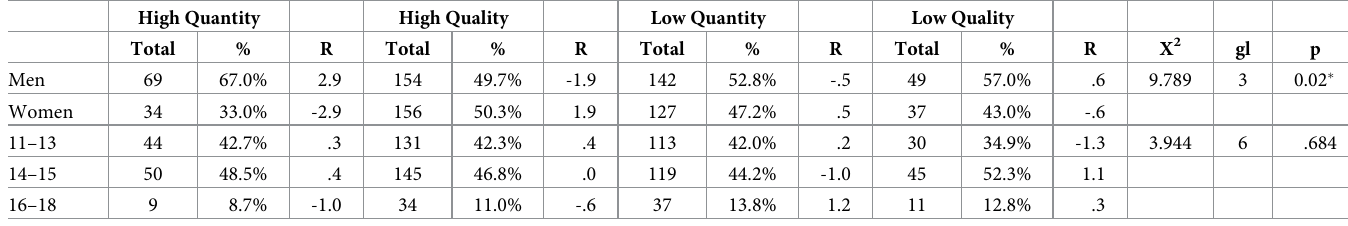
Table 5. Differences according to gender and